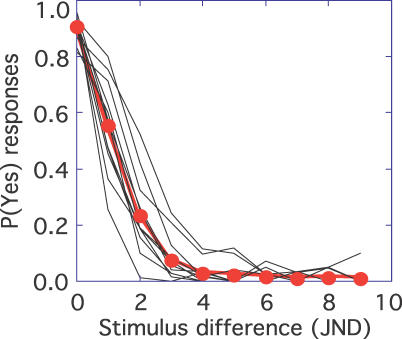
Proportion Yes Responses as a Function of Difference between Probe and To-Be-Remembered Item (in Units of JND)Twelve participants' data are shown in thin lines, with the average in thick red. These curves are well described by the exponential function of Equation 4. This function relates actual stimulus values to their mental representations. P(yes) responses indicate proportion of Yes responses.